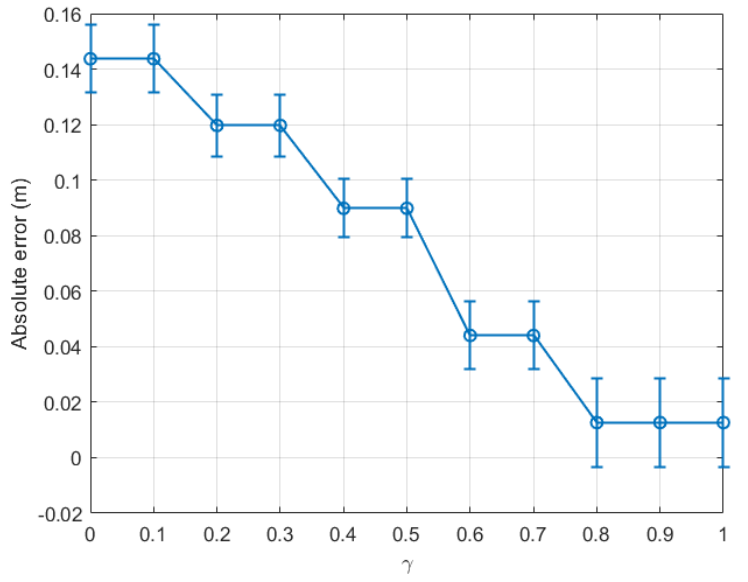
Figure 13. Indoor walking (dataset 5): absolute error of the last time window ( tw 18 ) with respect to γ ∈ [ 0,1 ] .